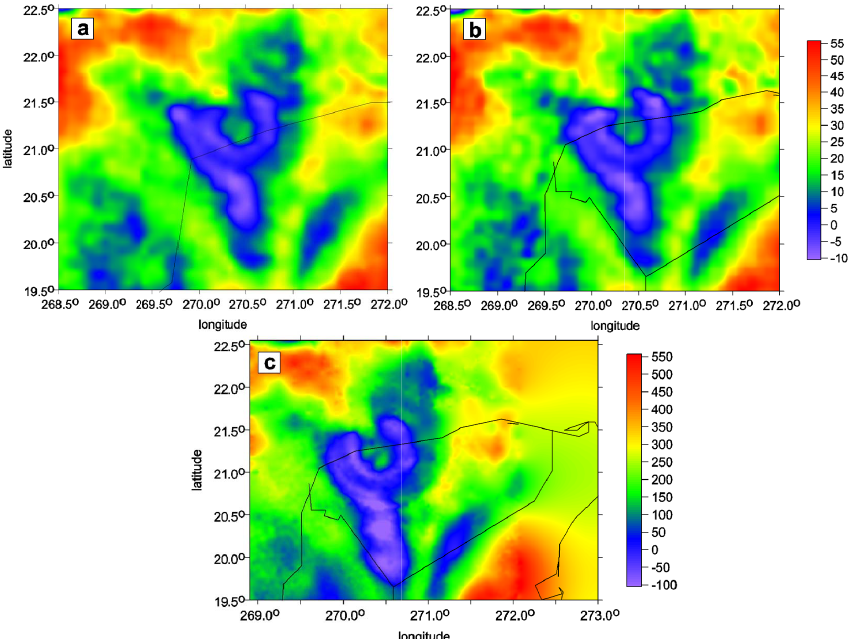
Fig. 7. Chicxulub, Yucat´an. Gravity anomalies computed with DNSC08, resolution 2 × 2 0 (a) as compared to those with EGM2008, resolution 5 × 5 0 (b) . Terrestrial gravity anomalies as used, e.g., by Hildebrand et al. (1995), (c) . To be compared to panels (a) and (b); in panel (c) the units are “gu” or “GPU” (geopotential units), 1GPU=10m 2 s − 2